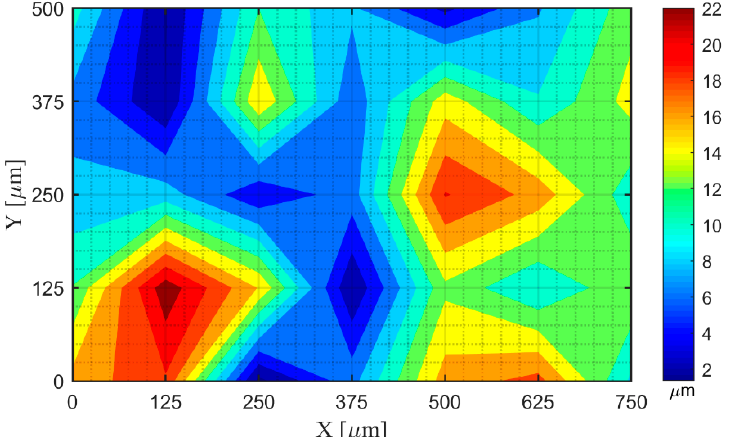
Figure 23. Comparison of the error vectors between the measured and corrected points of Simulation No. 10. As the results above show, all the measured values are improved after geometric error correction. It can be concluded that our developed algorithm for the determination of correction coefficients is valid. 6. Conclusions The work presented herein is Part I of the whole work, describing our methods for characterization and correction of lateral stage geometric errors. With implementation of the 21 parametric errors based on the assumption of the rigid body kinematics for calculating the machine volumetric errors of a three ‐ axis machine, a mathematical model for correcting the lateral stage deviations of the CM was developed. According to the measurement principle of CM, a diagram of the axis chain vector was drawn. Equation (1) was developed according to the kinematic path of the chain vector. After the rearrangement of Equation (1) and its simplification by dropping Z  and T  , this equation was further simplified due to the study specifications and characteristics of the CM . The function errors were approximated by Legendre polynomials. Finally, Equations (4) and (5) for corrections of kinematic geometric errors were obtained. The methodology for calculation and application of the